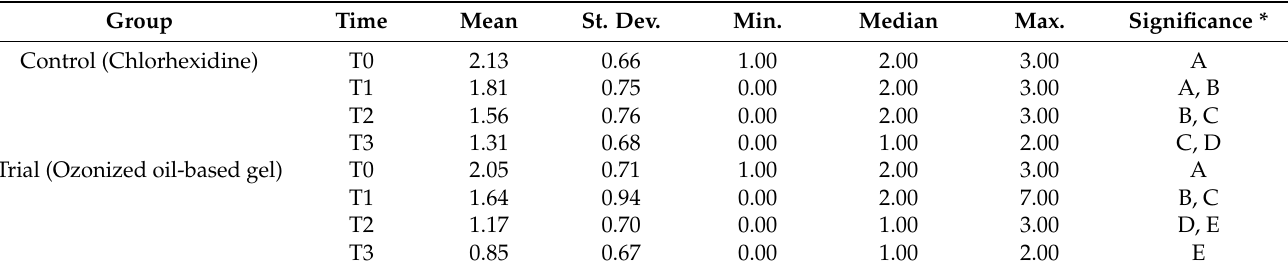
Table 8. Descriptive statistics of Bleeding Score (BS).